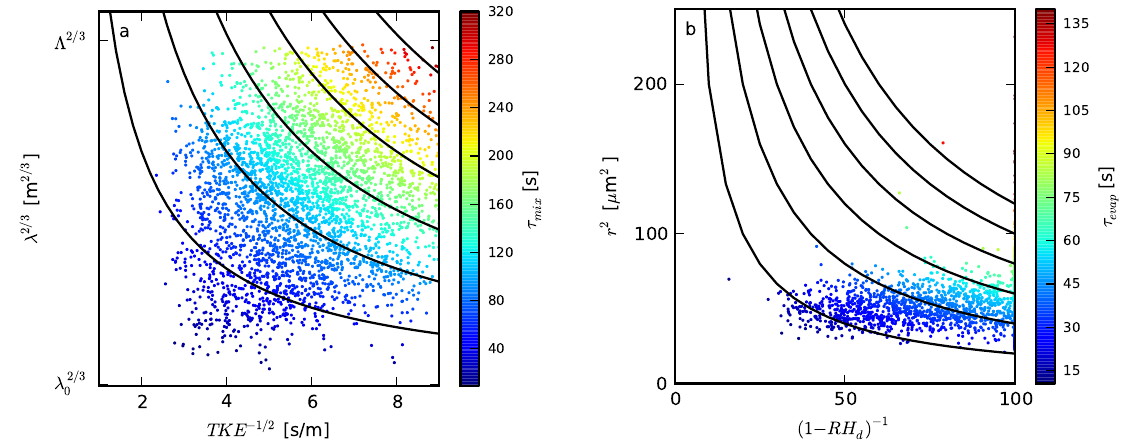
Fig. 14. Scatter diagrams of model variables (in appropriate powers; see Appendix A) that determine values of the τ mix (a) and τ evap (b) at the height of 500m (i.e., within the cumulus layer). Color scale and black lines mark values of the time scales.